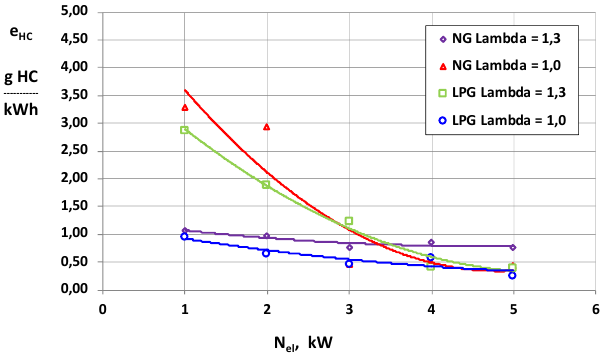
Fig. 6. Specific emission of HC vs mCHP unit output electric power